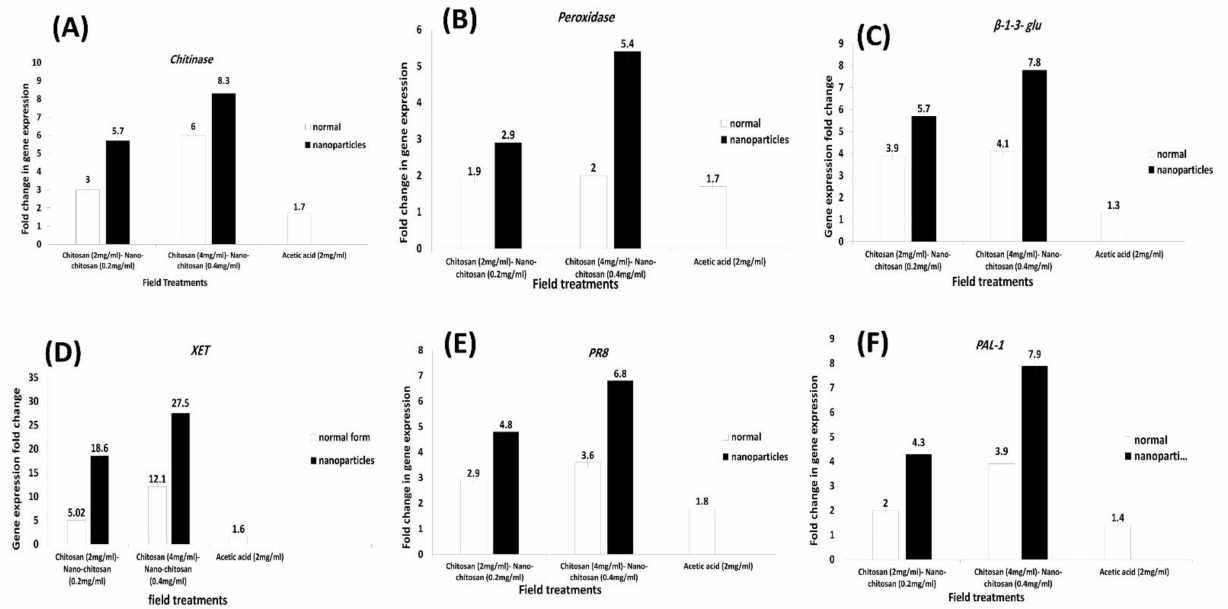
Figure 2. Relative expression profiles of six defense-related genes in apple leaves (Anna cv.) using qRT-PCR analysis. Plants were treated with chitosan NPs at 0.2 and 0.4 mg/mL, chitosan bulk materials 2.0 and 4.0 mg/mL, and acetic acid at 2.0 mg/mL. The figure showed the expression profile of; ( A ) chitinase gene; ( B ) peroxidase gene; ( C ) β -1,3-glucanase ( β -1,3- gluc ); ( D ) Xyloglucan endotransglycosylase (XET) ; ( E ) pathogenesis-related protein (PR8) ; and ( F ) Phenylalanine ammonia lyase-1 (PAL1). The qPCR data were normalized with the EF-1 α gene, the reference, (XM008387060). Error bars represent standard